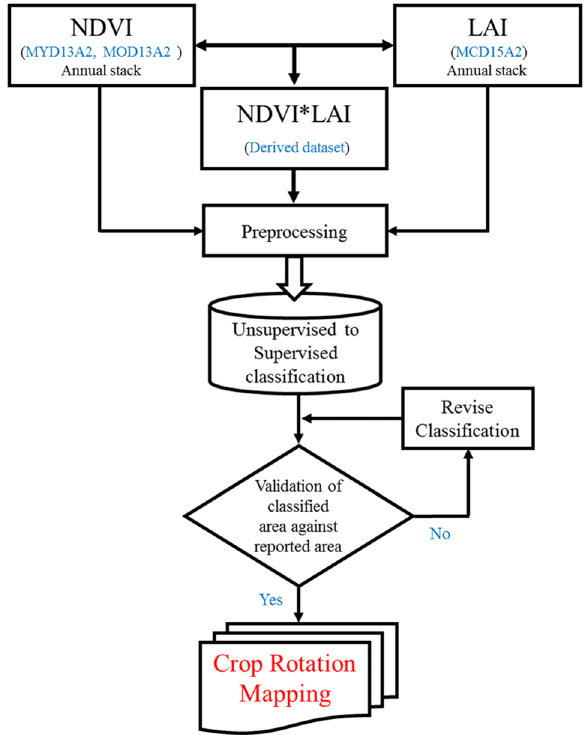
Figure 2. Flow diagram of